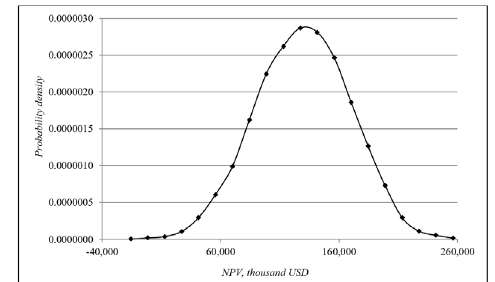
Fig. 5. The probability density function of the ENPV of the optimal real options portfolio